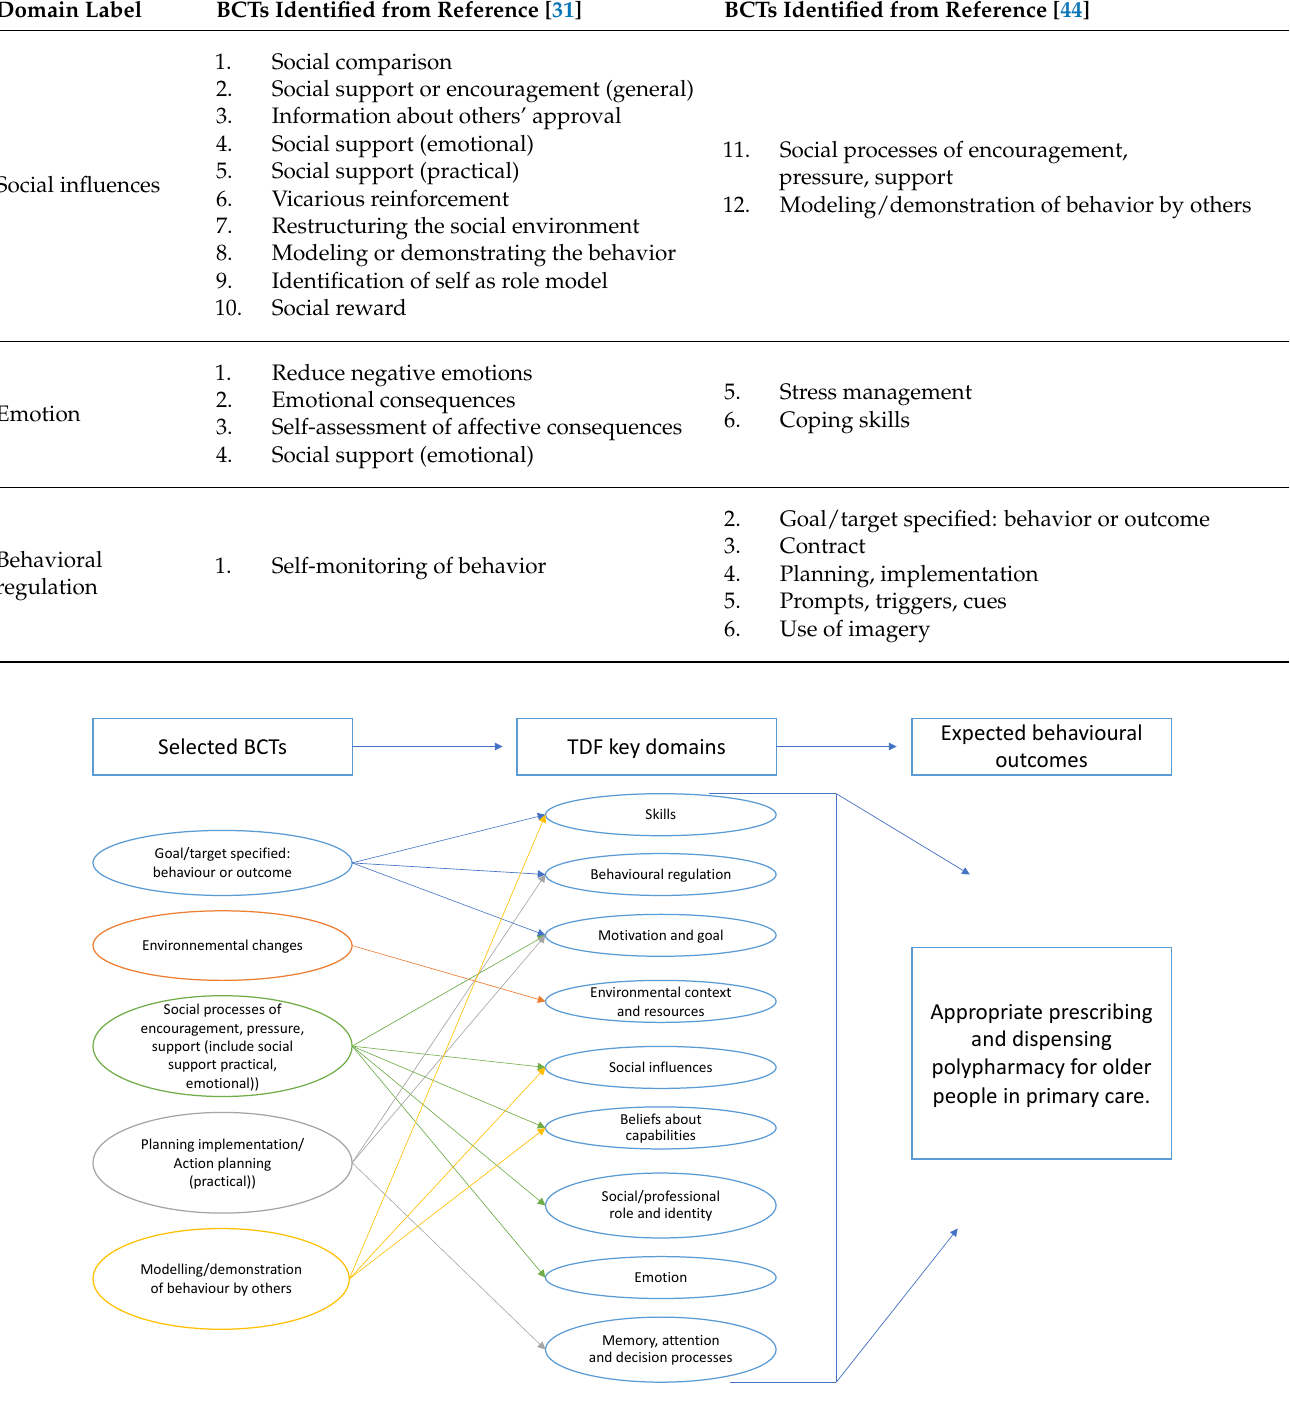
Figure 2. Selected behavior change techniques by key theoretical domains.